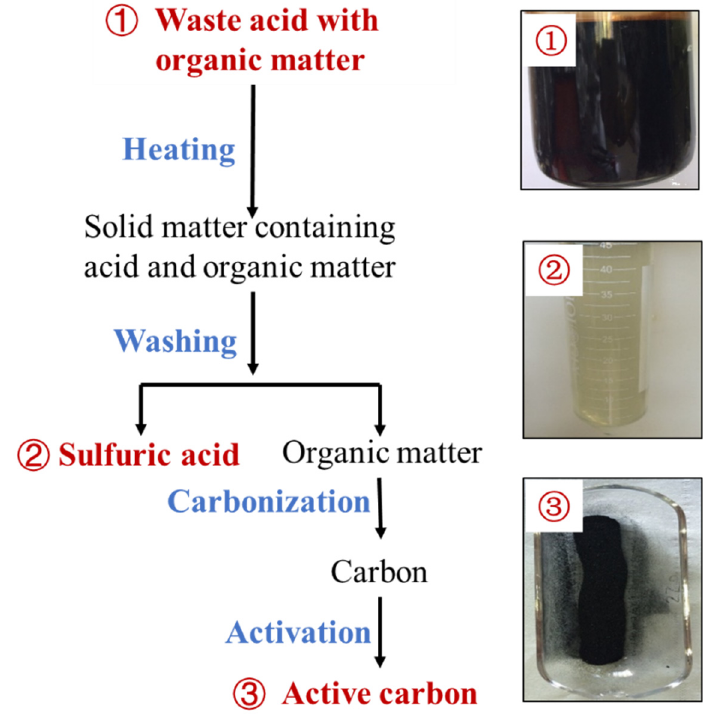
Figure 1. Recycling pathway of petroleum refining acid waste.